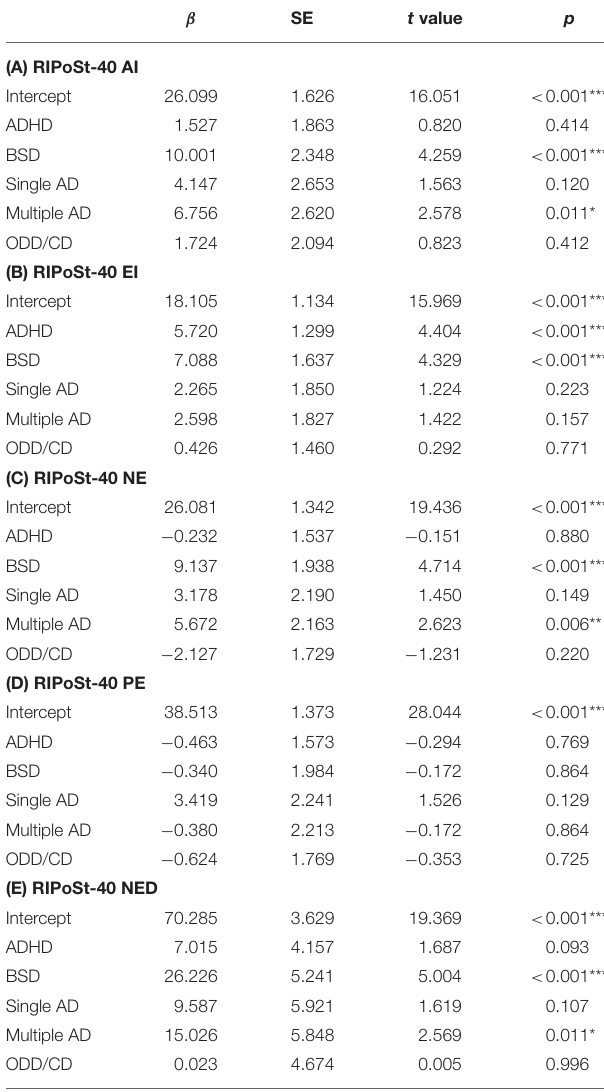
TABLE 5 | Linear regression models with clinical TABLE 4 | RIPoSt-40 and CBCL-6/18 subscale correlations. RIPoSt-40 RIPoSt-40 RIPoSt-40 RIPoSt-40 RIPoSt-40 AI EI NE PE NED